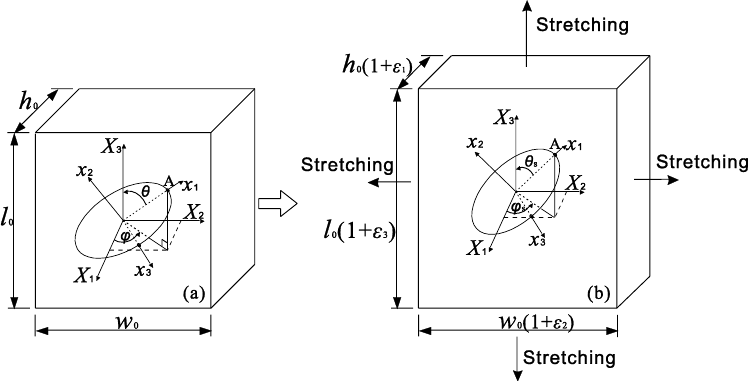
Figure 2. Re-orientation of GPL in a cell subjected to bi-axial stretching.